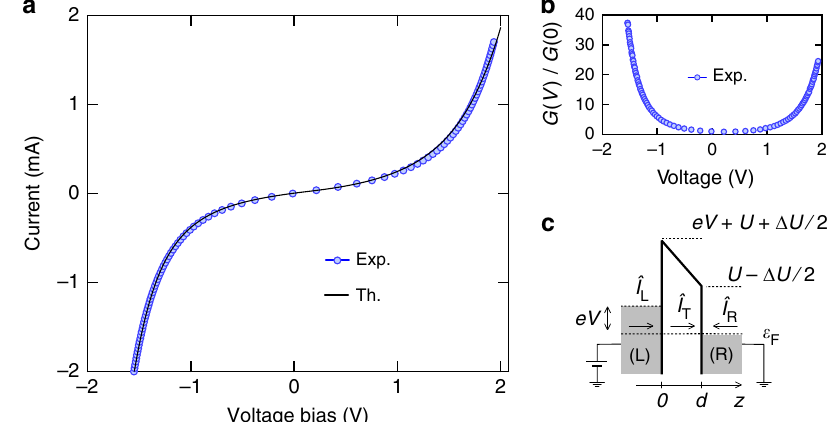
Fig. 2 Characteristic of the tunnel junction. a Symbols are experimental data and solid lines are theoretical expectations of Eq. (2) using the WKB approximation on a trapezoidal barrier characterized by a mean height U and an asymmetry Δ U . b Differential conductance vs. voltage at low bias. c Schematic of the trapezoidal barrier modi fi ed by a bias voltage V NATURE COMMUNICATIONS| (2018) 9:4940 |DOI: